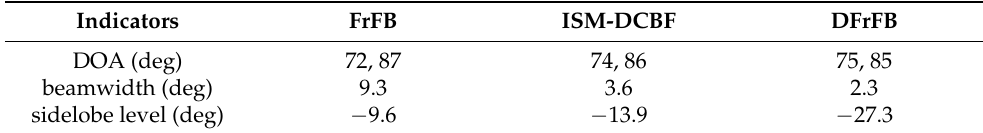
Figure 2. Spatial spectra of the simulation. Table 2. The performance of the